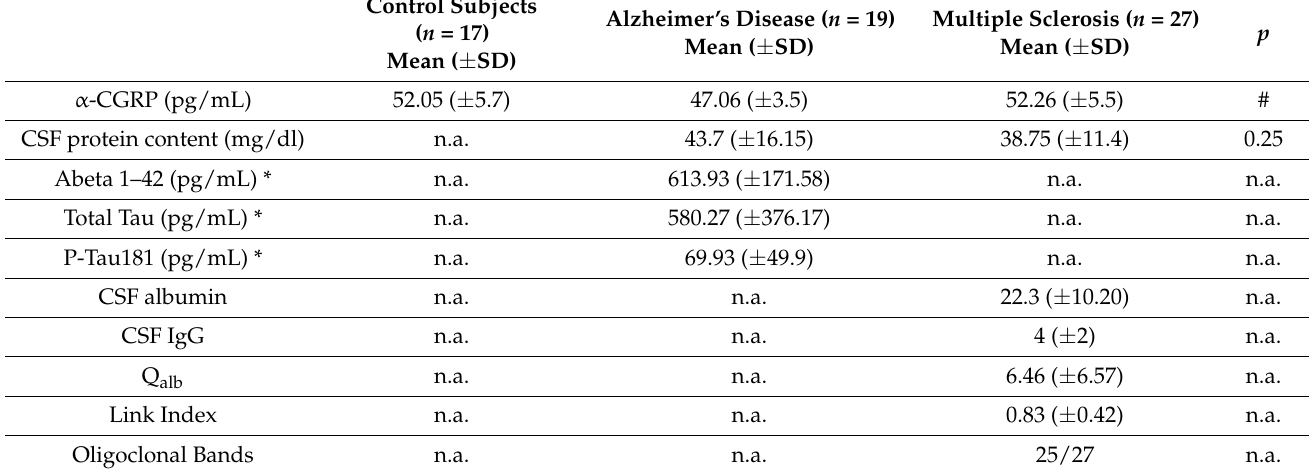
Table 2. Overview of the CSF physical–chemical, nephelometric parameters and α -CGRP in the study cohort. Control